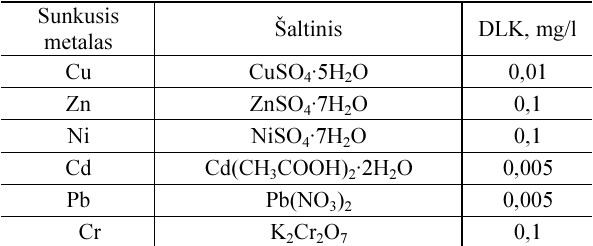
Table 1. Heavy metal concentrations affecting perch and roach